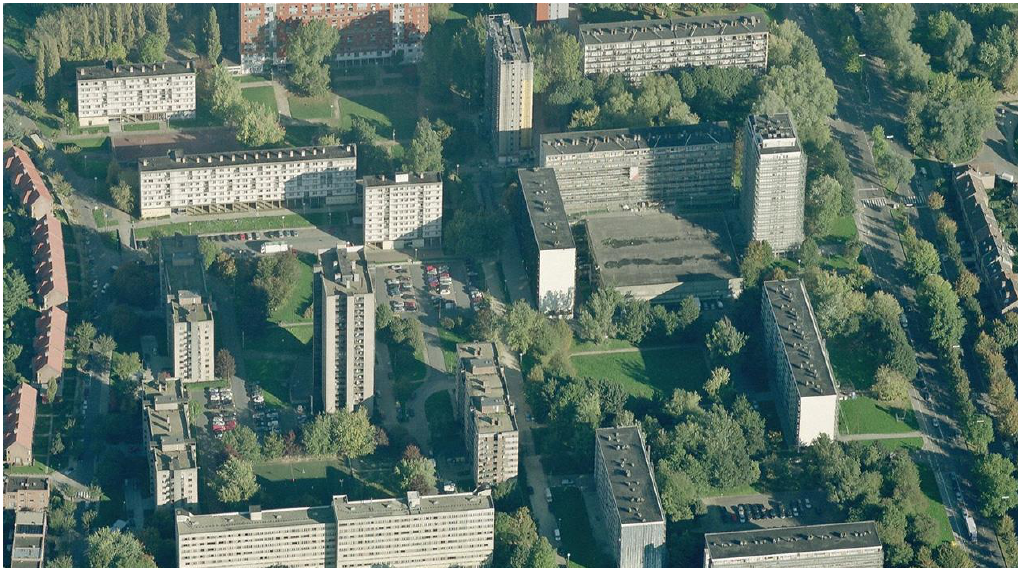
Figure 4 . Peterbos (2014). Source data: Bing Maps